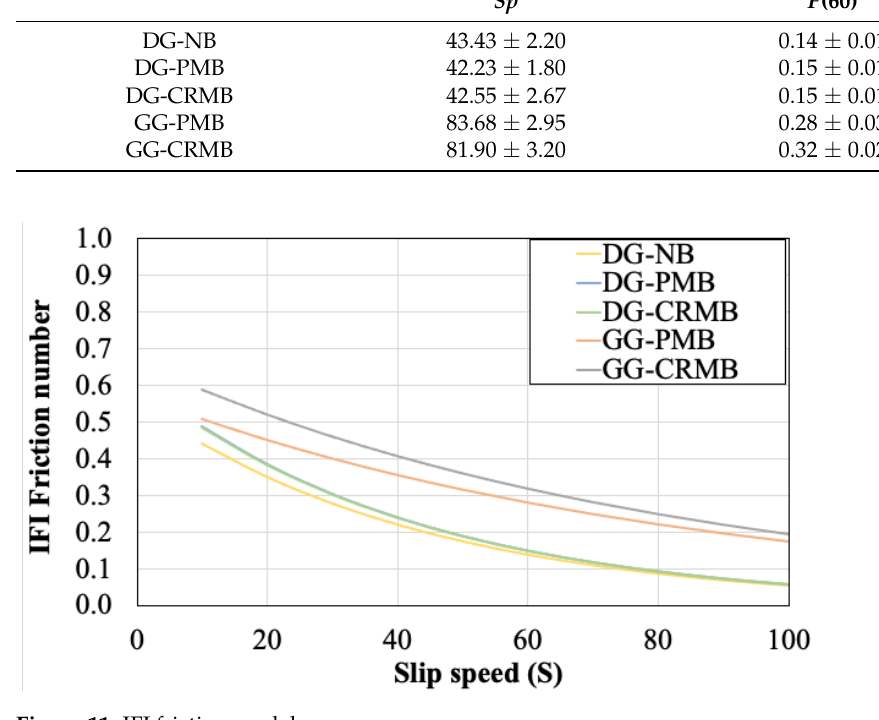
Figure 11. IFI friction models.